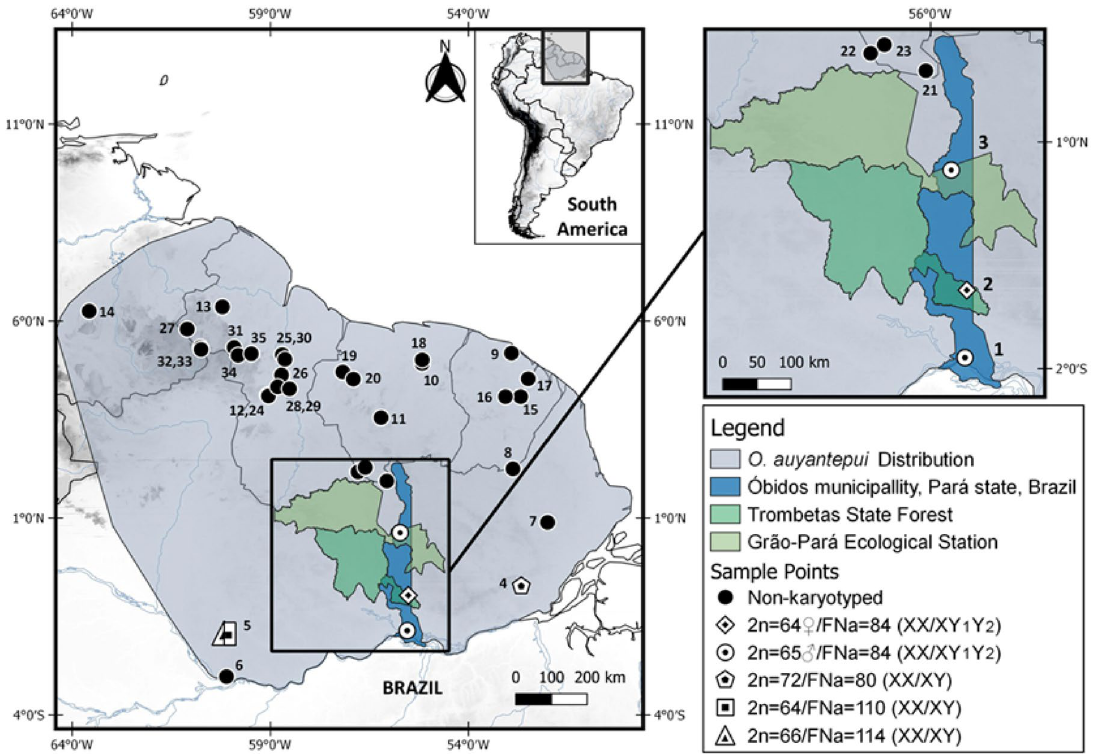
Figure 8. Map showing the distribution, study area and sampling points for Oecomys auyantepui specimens analysed in the present study and from literature. Available karyotypic information is shown with description of 2n (diploid number), FNa (autosomal fundamental number), and if is associated with simple (XX/XY) or multiple (XX/XY 1 Y 2 ) sex system. Each symbol indicates the karyotype obtained from the locality; more than one symbol indicates that distinct karyotypes were collected at the same locality. Geographic limits of O. auyantepui are based on sample points provided in the present study (localities 1–3), and from literature: locality 4 52 , locality 5 53 , localities 6–14 39 , and from GenBank (localities 15–35). The localities mentioned are: Brazil: Pará, Óbidos, forest fragment 7 km distant from the town’s center (locality 1); Trombetas State Forest (locality 2); Grão-Pará Ecological Station (locality 3); Jari River (locality 4); Amazonas, Jatapú River (locality 5); 80 km North of Manaus (locality 6); Amapá, Serra do Navio (locality 7). French Guiana: Trois Sauts (locality 8); Paracou (locality 9). Suriname: Brokopondo, Brownsberg Nature Park (locality 10); Sipaliwini, Avanavero Falls, Kabalebo River (locality 11). Guyana: Upper Takutu–Upper Essequibo (locality 12), Cuyuni-Mazaruni, Kartabo, Cuyuni River (locality 13). Venezuela: Bolívar, Auyan-tepuí, South slope, Río Caroni (locality 14). Samples obtained from GenBank (localities 15–35) are detailed in Supplementary Table